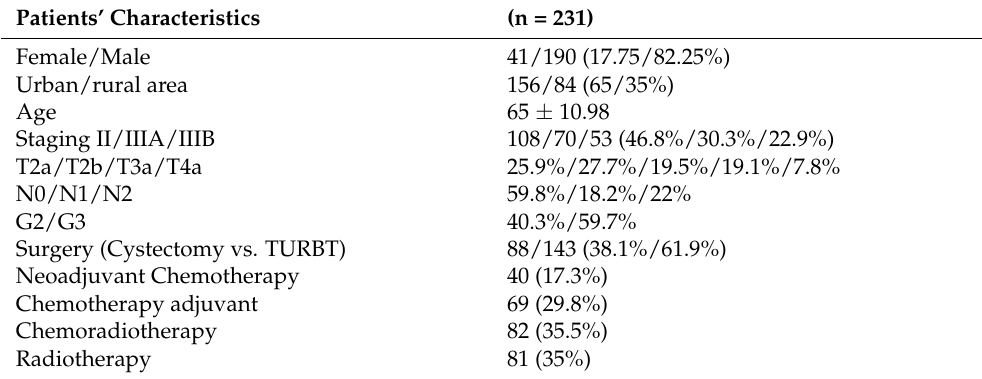
Table 1. Patients’ demographic characteristics.